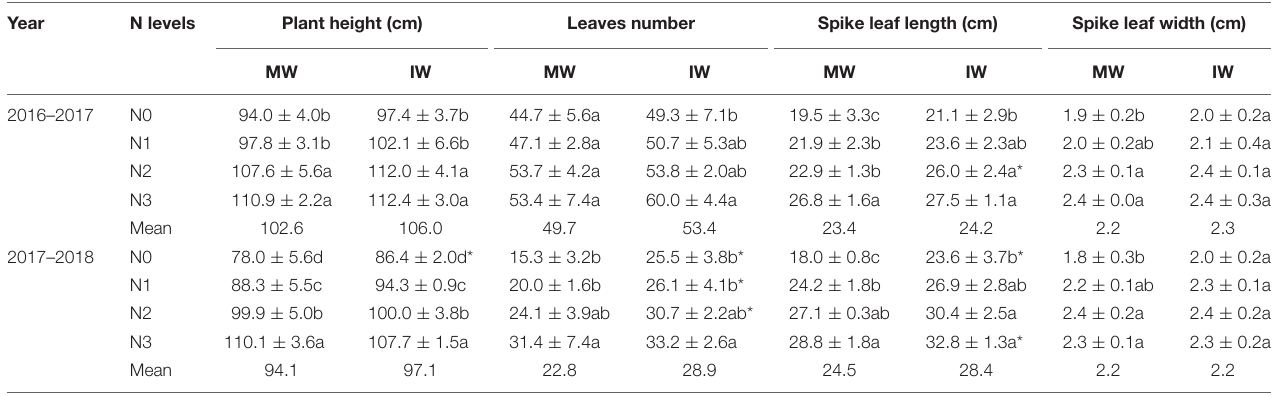
TABLE 2 | Effects of applied nitrogen and intercropping on wheat growth parameters in the mean of two growing seasons. Year N levels Plant height (cm) Leaves number Spike leaf length (cm) Spike leaf width (cm) MW IW MW IW MW MW